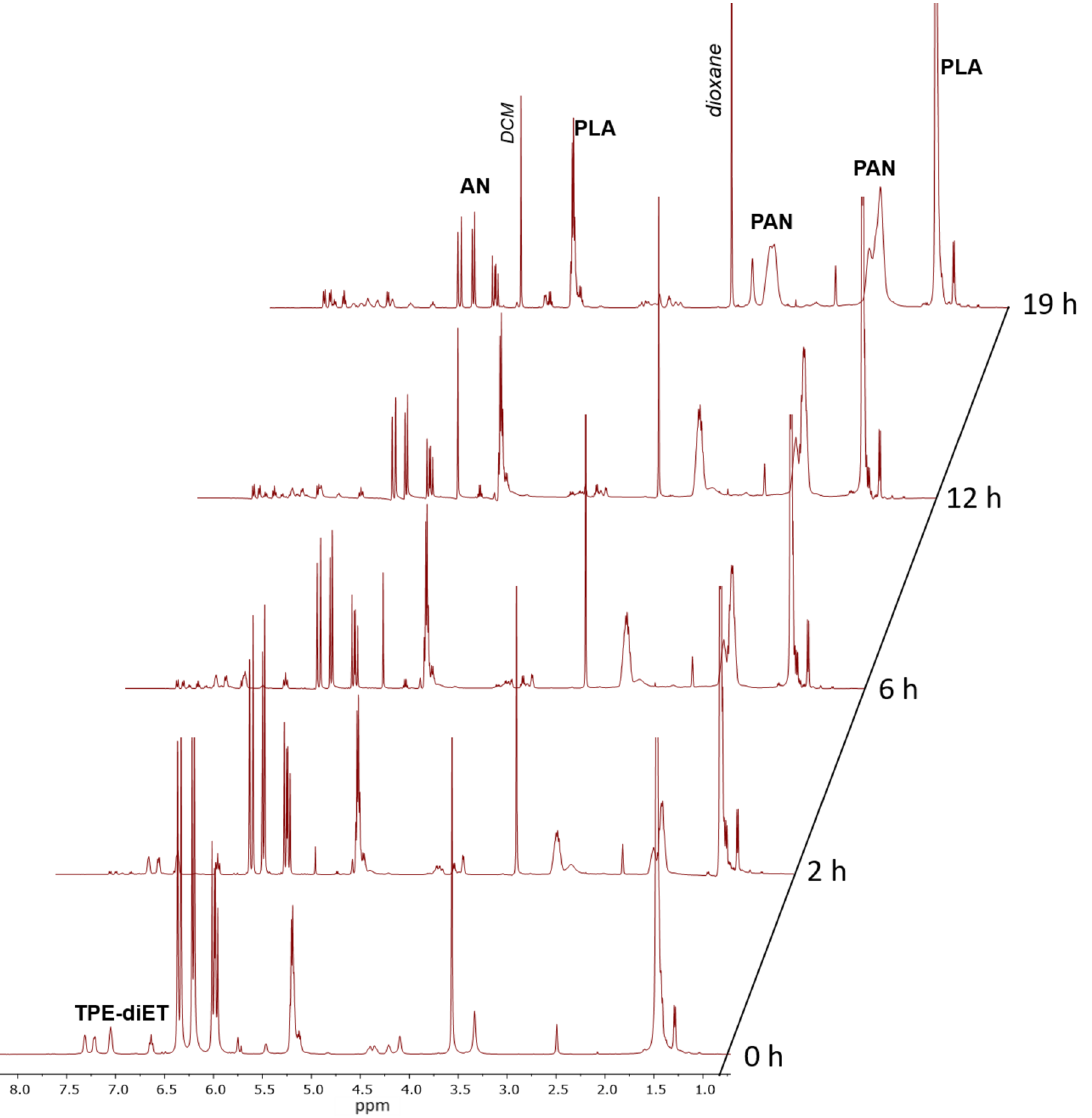
Figure 5. 1 H NMR spectra of the solution of TPE-diET_PLA reacting with acrylonitrile in DMSO-d 6 at 85 ◦ C recorded at different